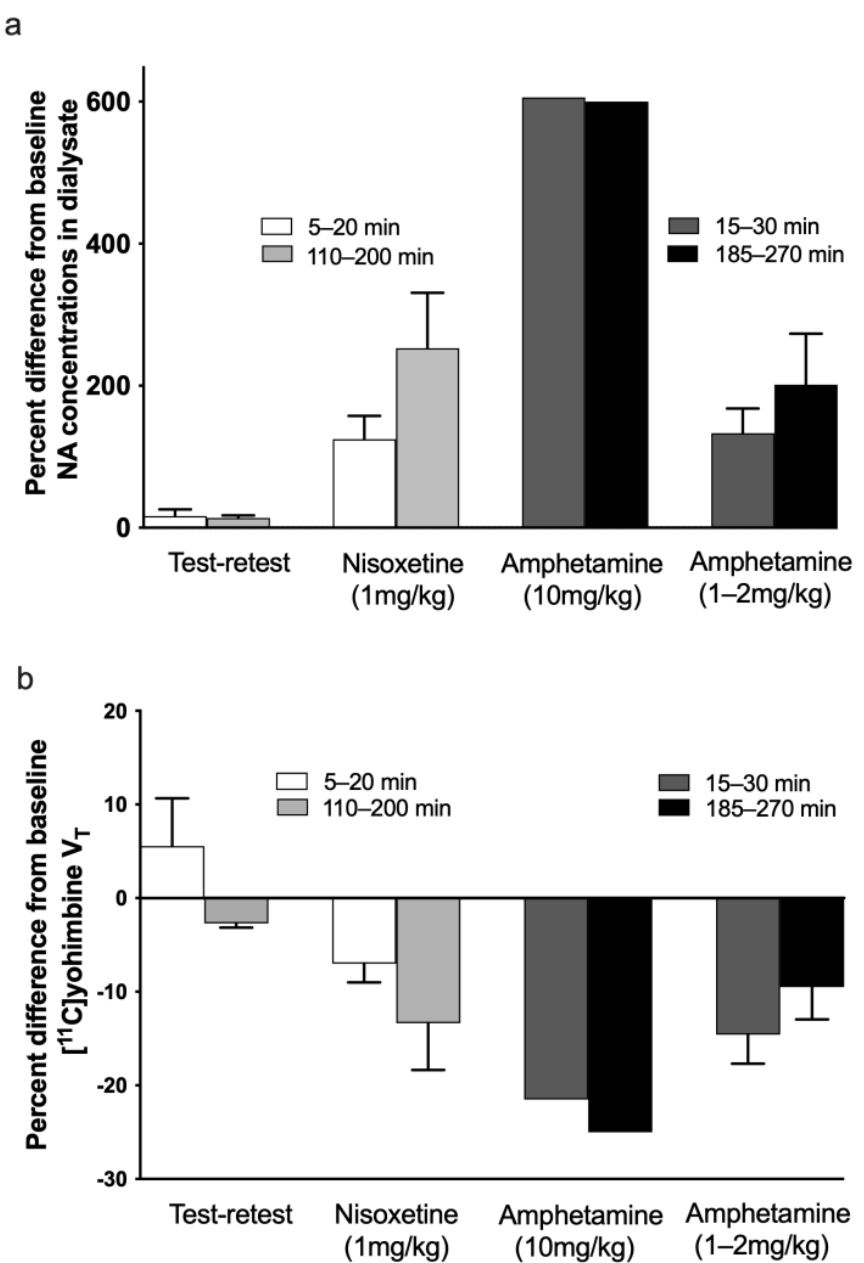
Figure 5. Averaged percent change from baseline to post-drug challenge in the extracellular con- centration of NA ( a ) and volume of distribution V T of [ 11 C]yohimbine ( b ). ( a ) Percent change of extracellular NA concentration is shown during the time frame of scans 1 and 2 and scans 1 and 3 for the test–retest ( n = 3), nisoxetine ( n = 3) and 10 mg/kg ( n = 1) and 1–2 mg/kg ( n = 3) am- phetamine conditions. The extracellular NA levels in the cortical and thalamic probes were averaged for representation and match the time frame of the PET scans. ( b ) Averaged percent change from baseline in the volume of distribution V T of [ 11 C]yohimbine. Percent change is shown for scans 1 and 2 and scans 1 and 3 for the test–retest ( n = 3), nisoxetine ( n = 3) and 10 mg/kg ( n = 1) and 1–2 mg/kg ( n = 3) amphetamine conditions in the same animals for which dialysis data were available. The V T in the cortical and thalamic regions was averaged for representation. The shading of the test–retest/nisoxetine and amphetamine bars is different to bring attention to the different timing of the scan start time post-challenge (see legend in the